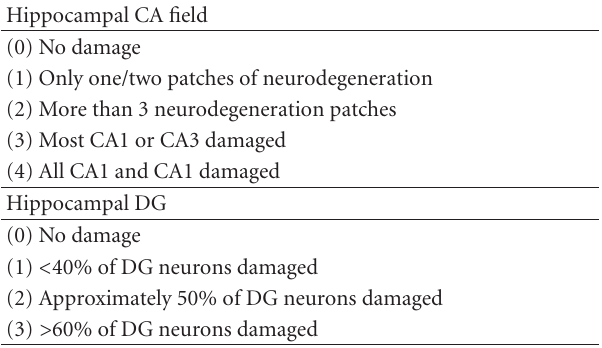
Table 2: Injury score grading system. Survival times from 7 to 100 days after